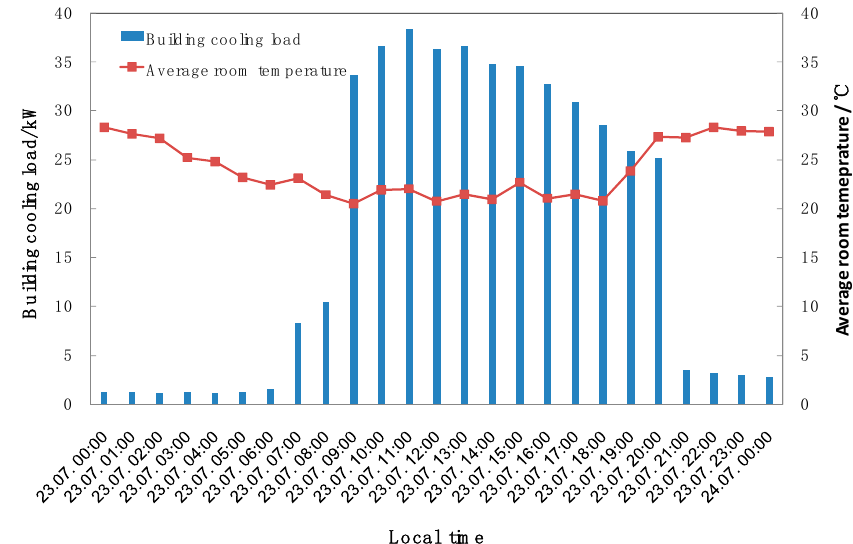
Figure 8. The monthly average outdoor temperature and building cooling and heating energy demand in 2018.